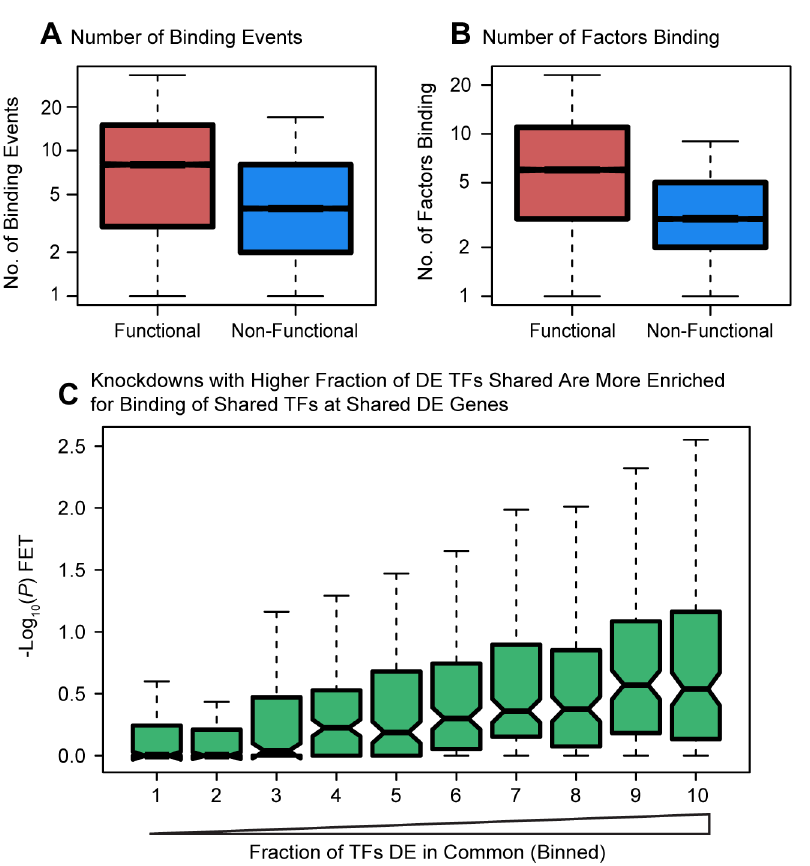
Figure 4. Degree of binding correlated with function. Boxplots comparing (a) the number of sites bound, and (b) the number of differentially expressed transcription factors binding events near functionally or non-functionally bound genes. We considered binding for siRNA-targeted factor and any factor differentially expressed in the knockdown. (c) Focusing only on genes differentially expressed in common between each pairwise set of knockdowns we tested for enrichments of functional binding (y-axis). Pairwise comparisons between knockdown experiments were binned by the fraction of differentially expressed transcription factors in common between the two experiments. For these boxplots, outliers were not plotted.